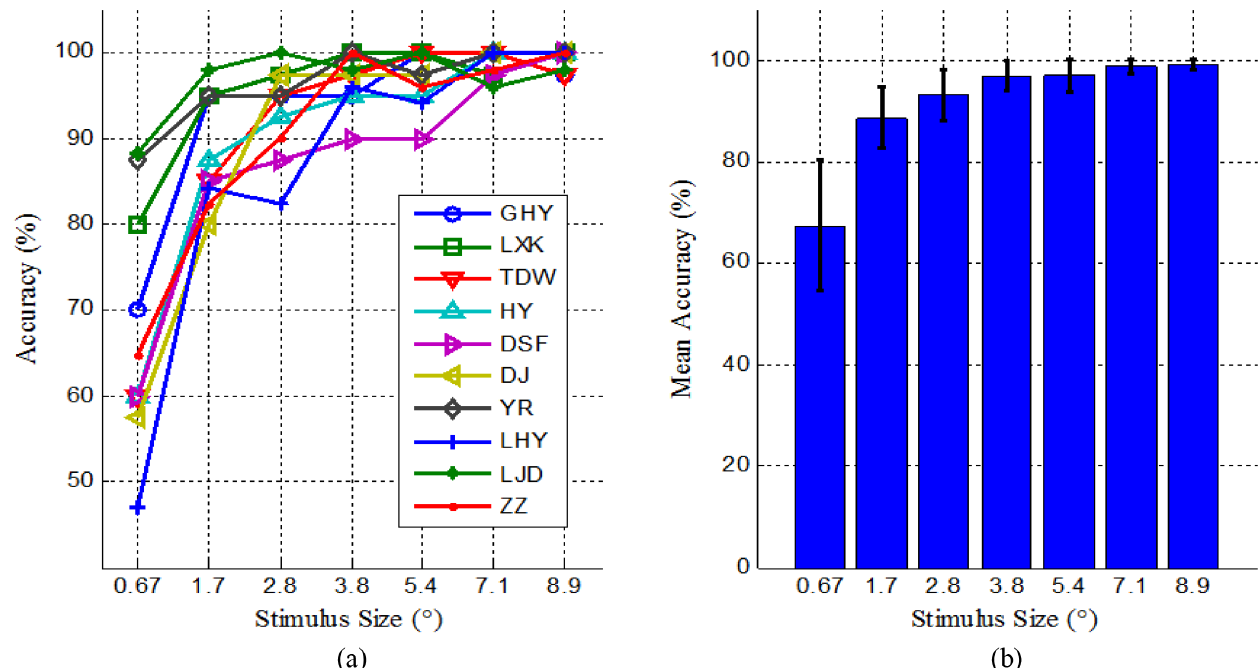
Fig 4. (a) The classification accuracy of each subject as a function of stimulus size; (b) Average classification accuracy across subjects for each stimulus size. The error bars represent standard